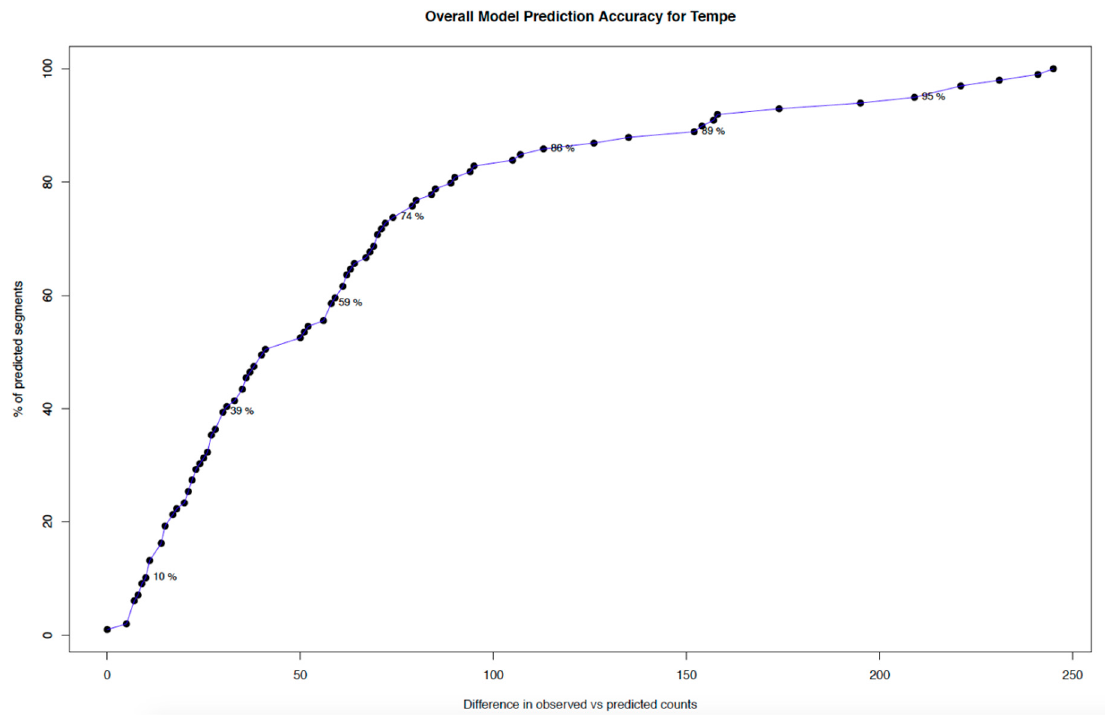
Figure 8. Model Prediction Accuracy for Tempe in 2016.